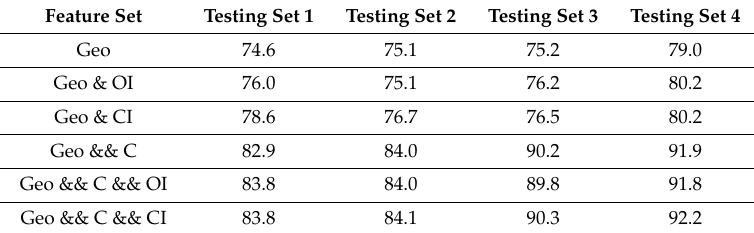
Table 3. Overall accuracy (in %) of four test cases for different feature sets.